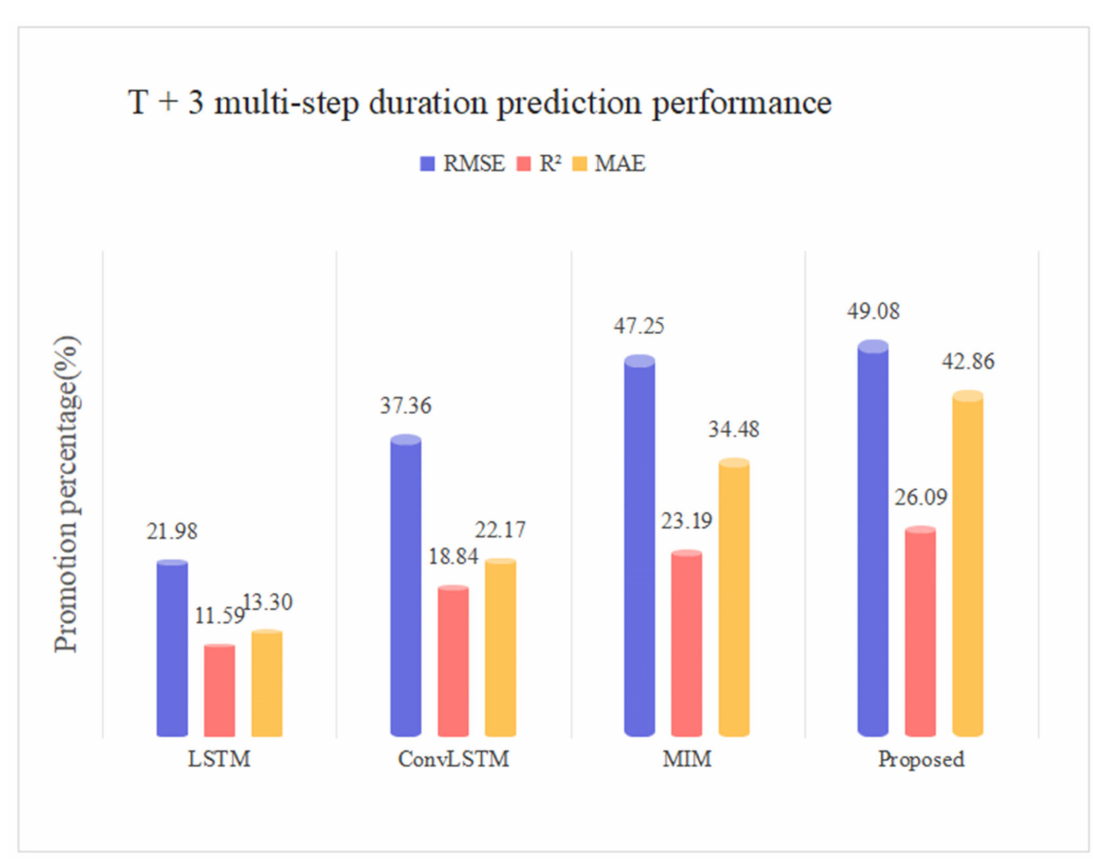
Figure 11. T + 3 multi-step duration prediction performance.